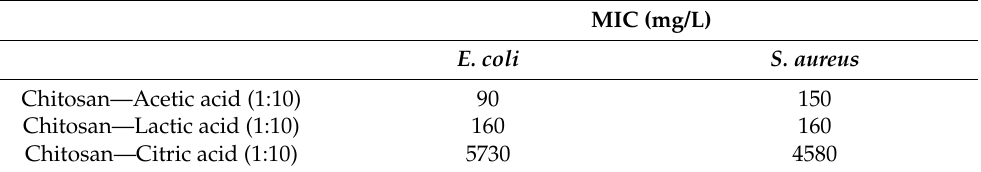
Table 1. Minimum inhibitory concentration (MIC) of chitosan dissolved using different acids against Escherichia coli ATCC 25,922 and Staphylococcus aureus ATTC